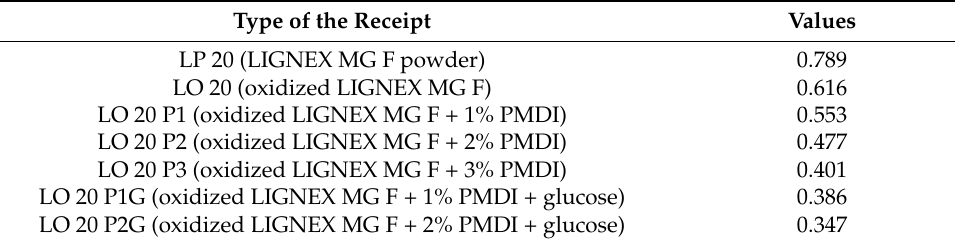
Table 6. Formaldehyde emission, in mg/ m 2 ·